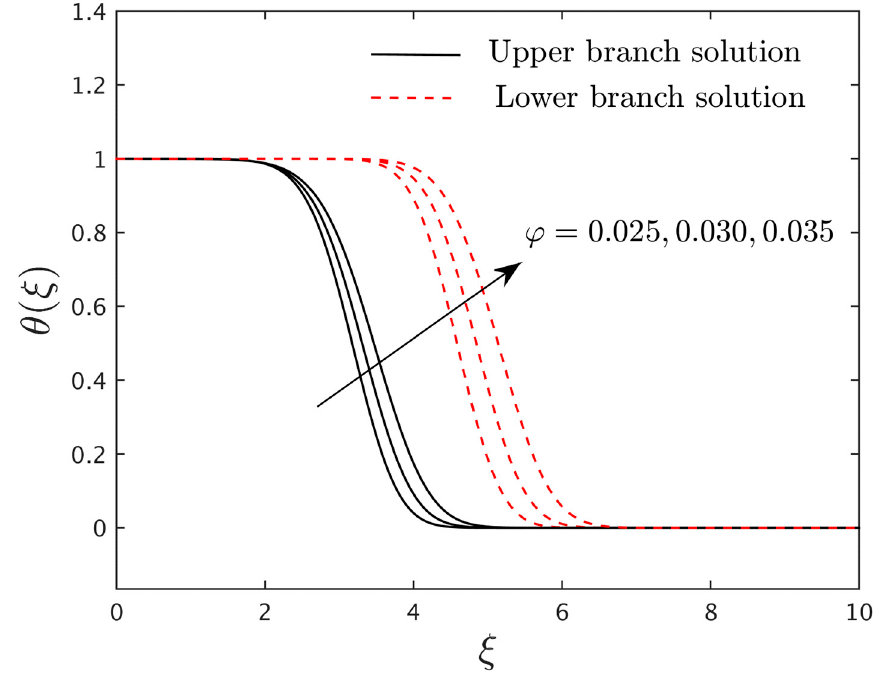
Figure 11. The temperature profiles θ ( ξ ) for the numerous values of ϕ when Pr a = 1.0, Sc a = 10.0, Pr = 6.2, Σ a = 0.05, and γ s = 0.5.